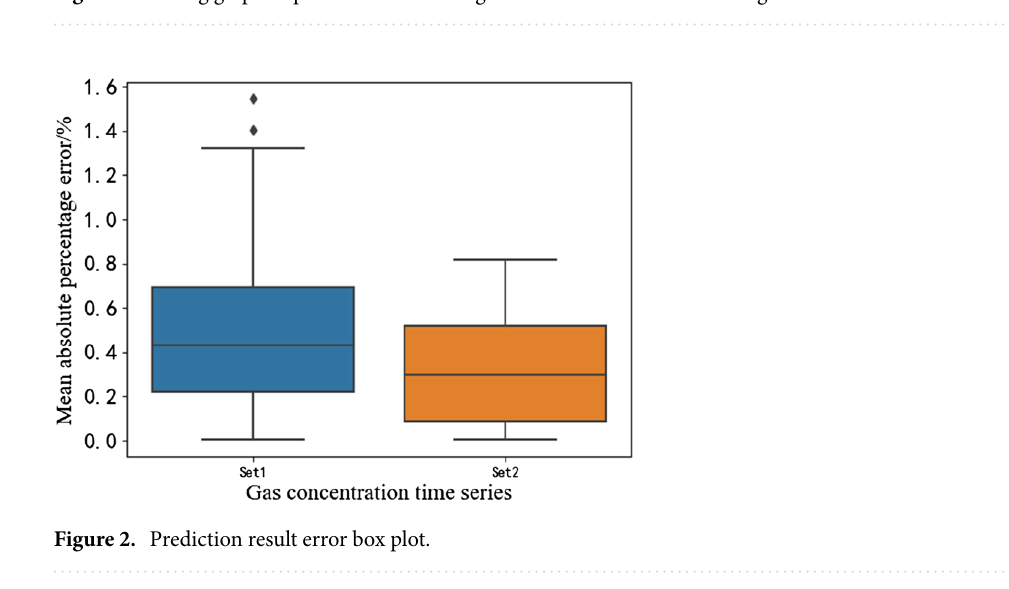
Figure 1. Fitting graph of prediction results of gas concentration in the working face based on the ANN.